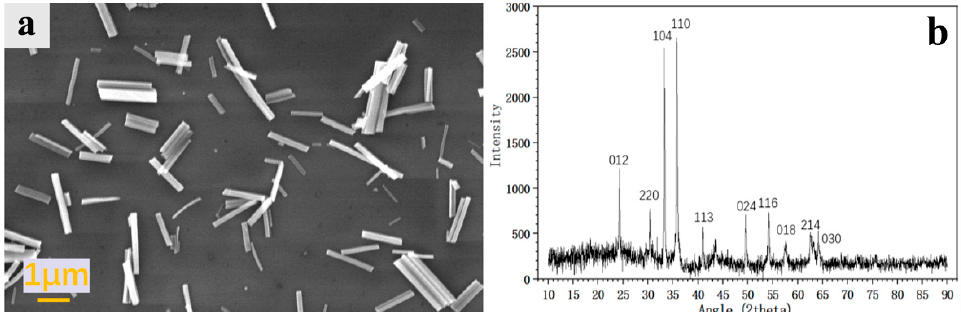
Figure 1. SEM photo ( a ) and XRD result ( b ) of as-grown Fe 2 O 3 nanowires.